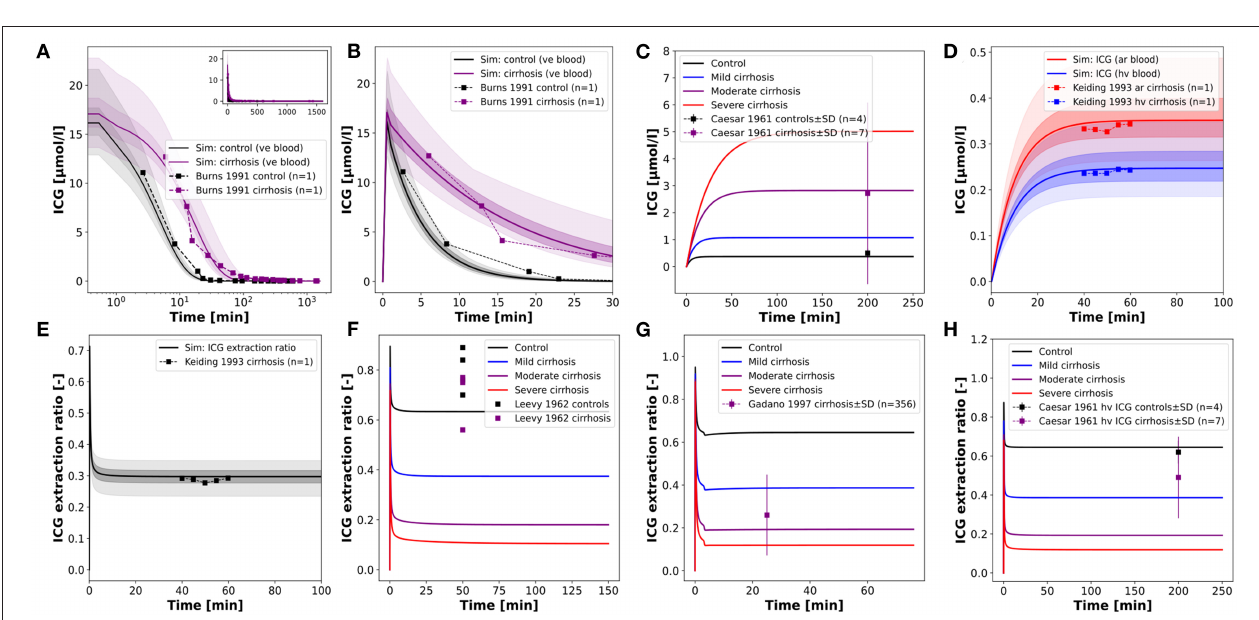
values were then compared between the patient